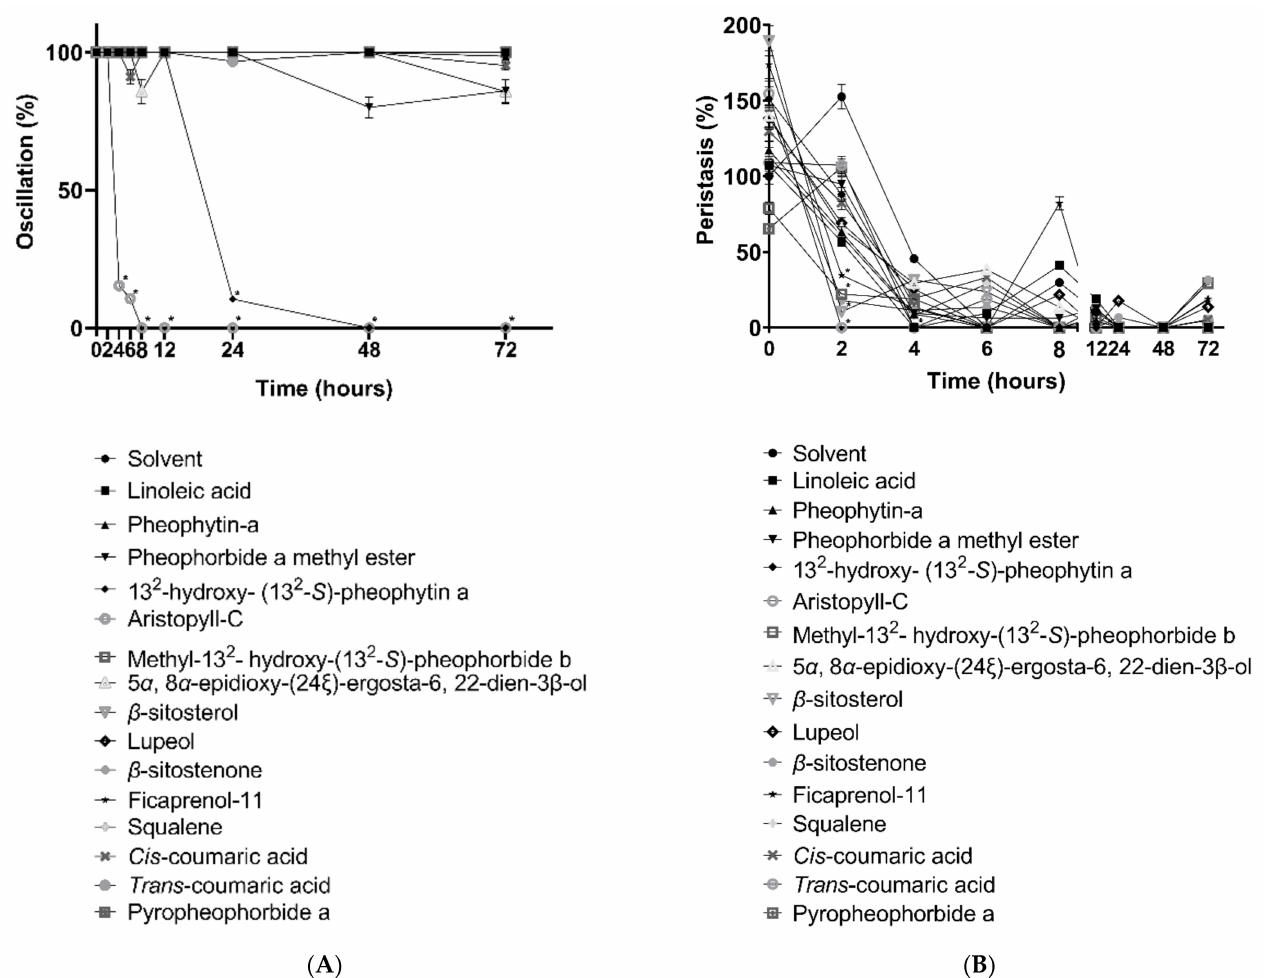
Figure 1. Effects of compounds isolated from Leucaena leucocephala on H. nana in the change of oscillation ( A ) and peristalsis ( B ) with linoleic acid, pheophytin-a, pheophorbide a methyl ester, 13 2 -hydroxy-(13 2 -S)-pheophytin a, aristophyll-C, methyl-13 2 -hydroxy-(13 2 -S)-pheophorbide b, 5 α , 8 α -epidioxy-(24 ξ )-ergosta-6, 22-dien-3 β -ol, β -sitosterol, lupeol, β -sitostenone, ficaprenol-11, squalene, cis-coumaric acid, trans-coumaric acid, pyropheophorbide a, and 1, 3-dipalmitoyl-2-oleoylglycerol. All components were tested in 100 µ M at 2, 4, 6, 8, 12, 24, 48, and 72 h. Solvent was 0.1% DMSO. Each data point represents the mean ± SD of three individual experiments. * p < 0.05: significantly different from